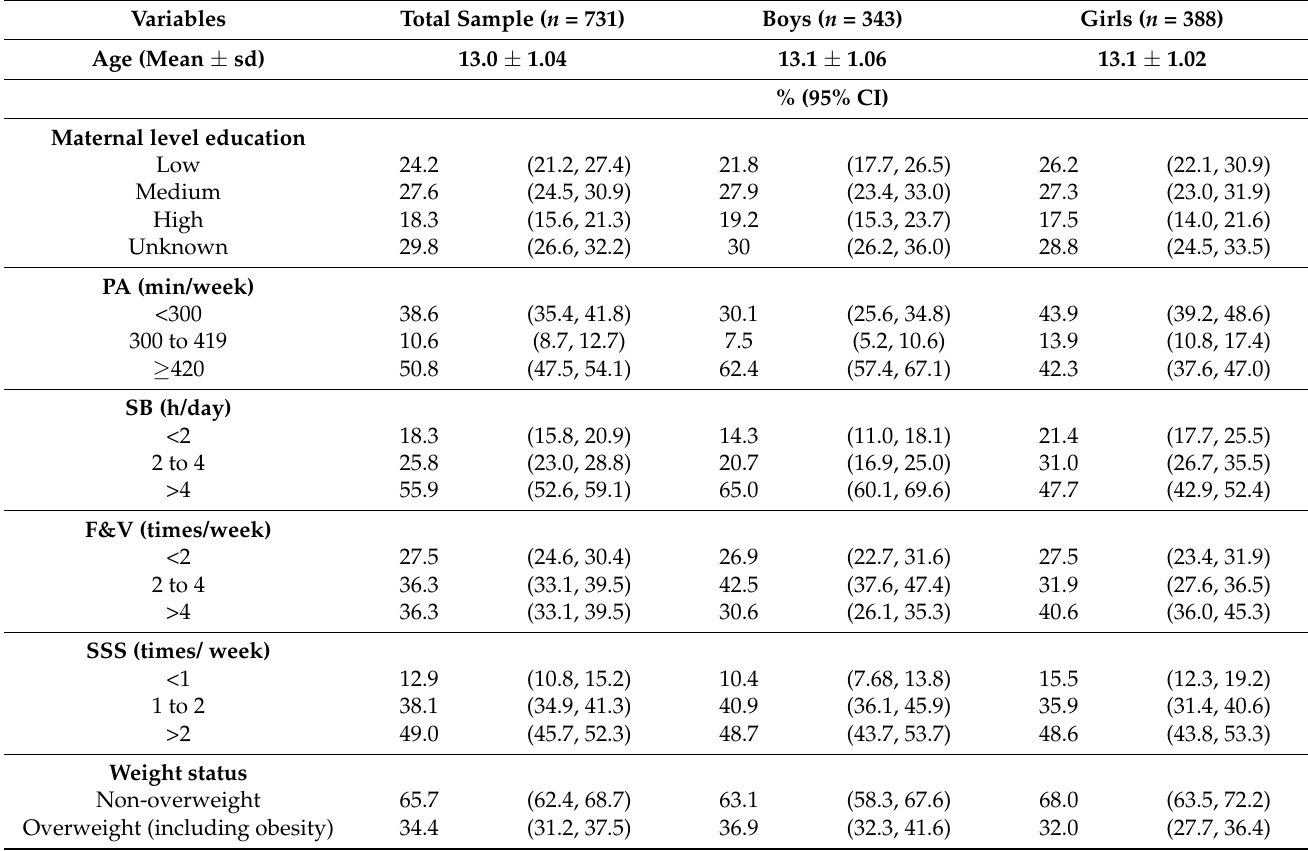
Table 1. Sample characteristics. Florian ó polis, Santa Catarina, Brazil,